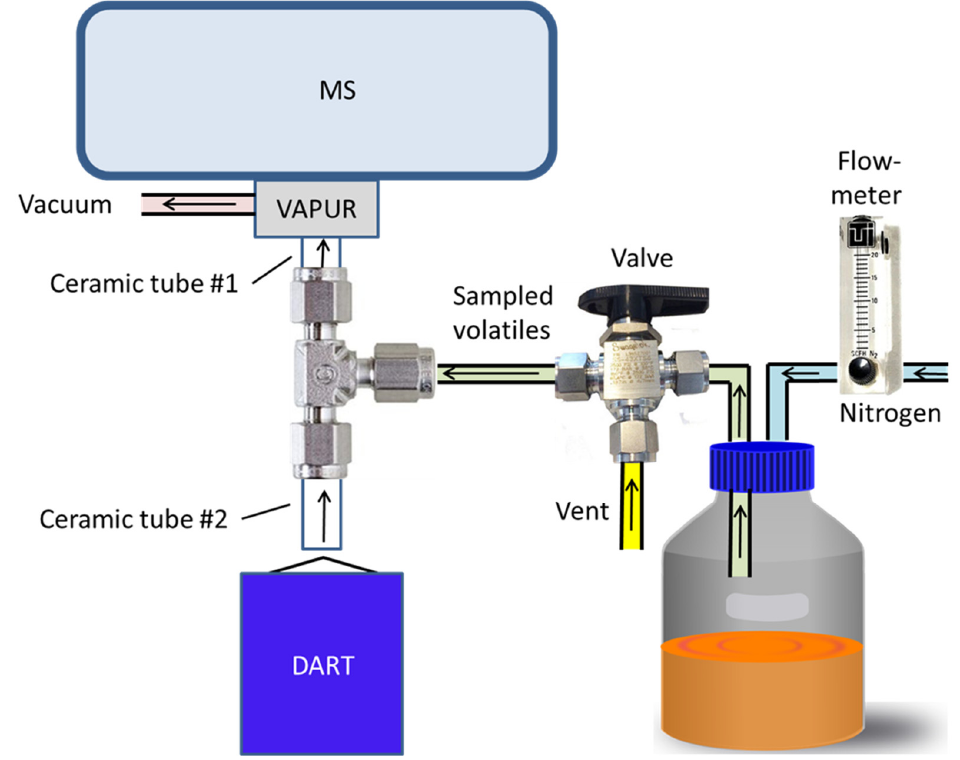
Figure 1. Cartoon representation of the modified DART–MS instrument constructed to allow convenient sampling of culture bottles.